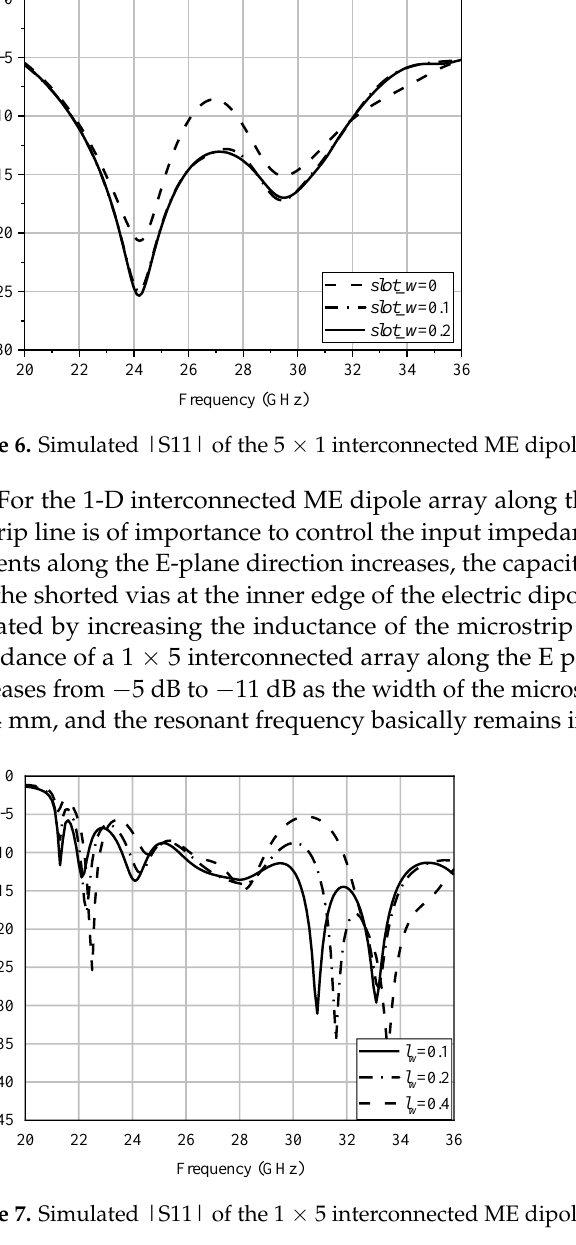
Figure 5. The equivalent circuit for the half structure of 1-D 5 × 1 interconnected ME dipole array with slot.